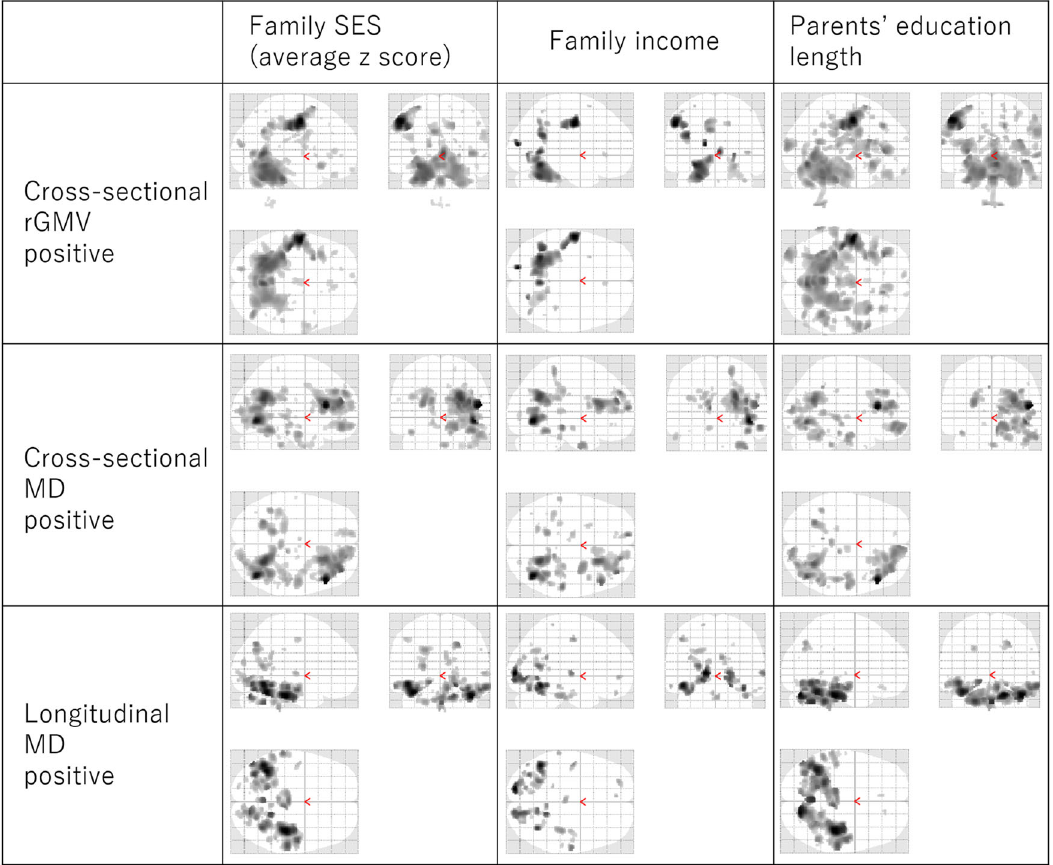
Fig. 5 Associations between childhood SES measures and brain structures. The fi gures in the left, middle, and right columns represent the associations of average z -scores for family income and parents ’ education length (left), family income alone (middle), and parents ’ education length alone (right), respectively. The fi gures in the upper, middle, and lower lines represent positive childhood SES associations with rGMV in the cross-sectional analyses (upper, N = 285), MD in cross-sectional analyses (middle, N = 253), and MD in longitudinal analyses (lower, N = 200). The results shown were obtained using an uncorrected threshold of P < 0.005. Associated regions are superimposed on a glass brain image from SPM. Associations shared by family income, parents ’ education length, and the average z-scores were